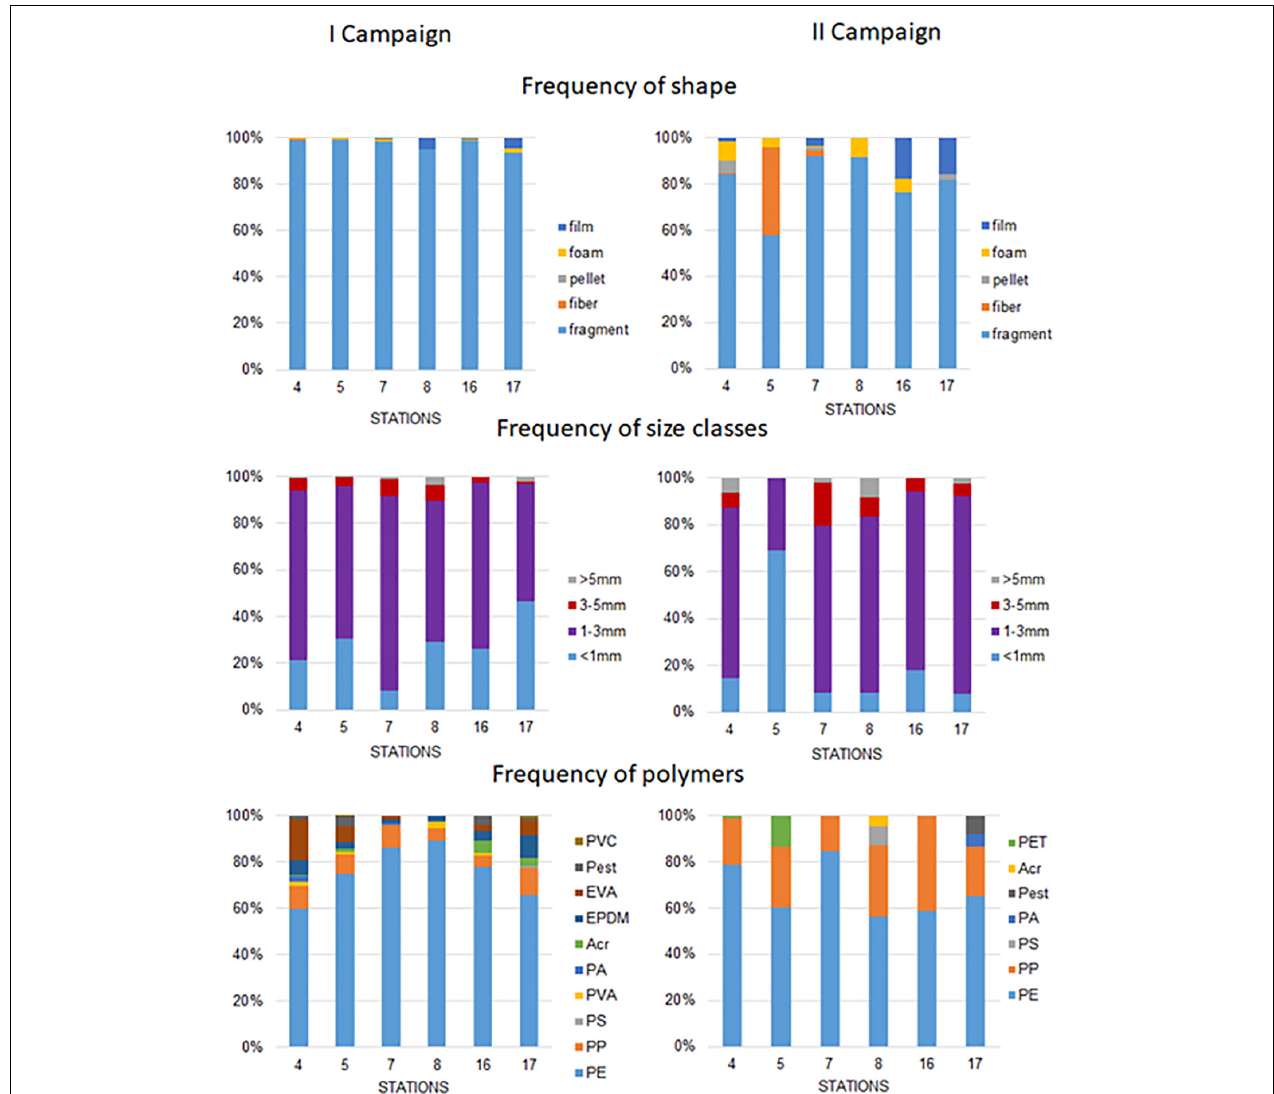
FIGURE 2 | Frequency (%) of particle shape, size classes and polymers extracted from water samples collected in Gulf of Gabes during I and II Campaign. PE, Polyethylene; PP, Polypropylene; PS, Polystyrene; PVA, Polyvinyl.